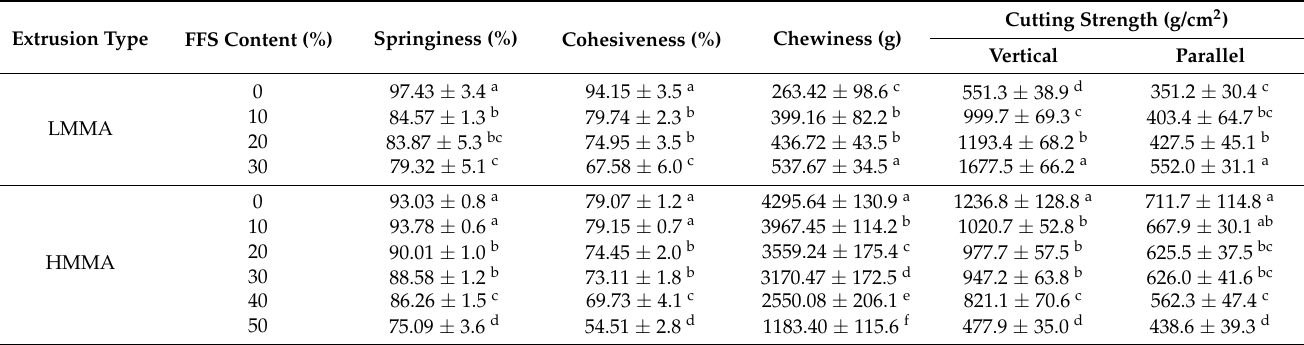
Table 2. Texture profile analysis and cutting strength (vertical and parallel) of meat analogs with various full-fat soy contents.